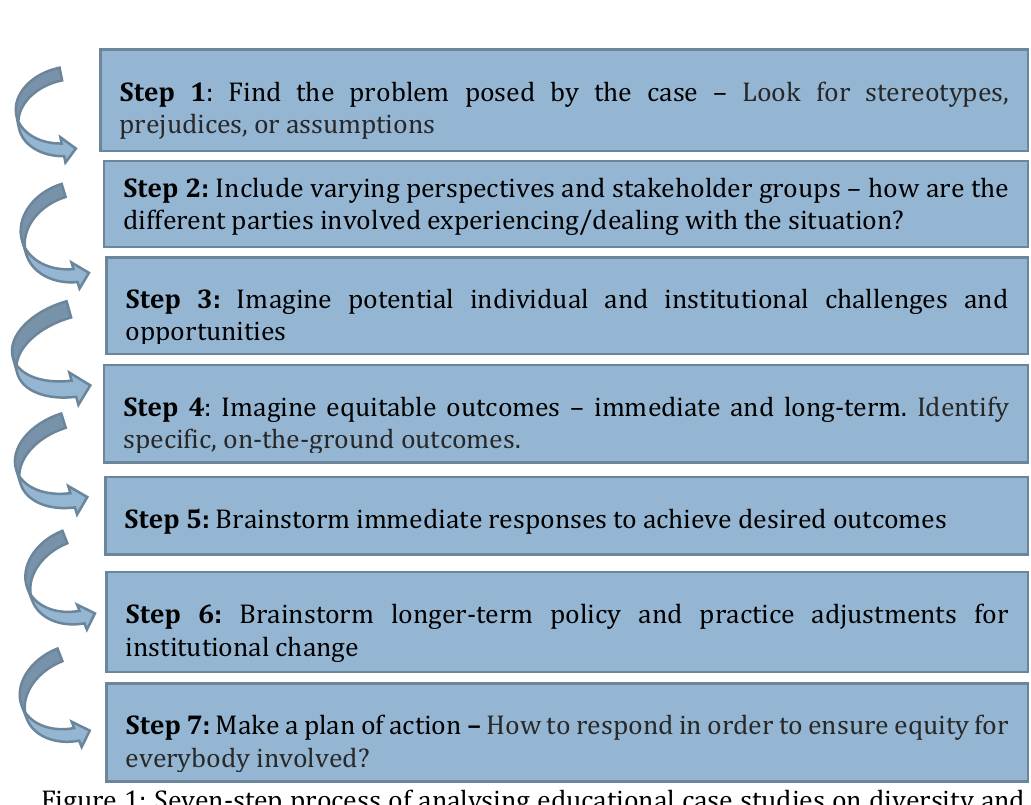
Figure 1: Seven-step process of analysing educational case studies on diversity and social justice, based on Gorski & Pothini